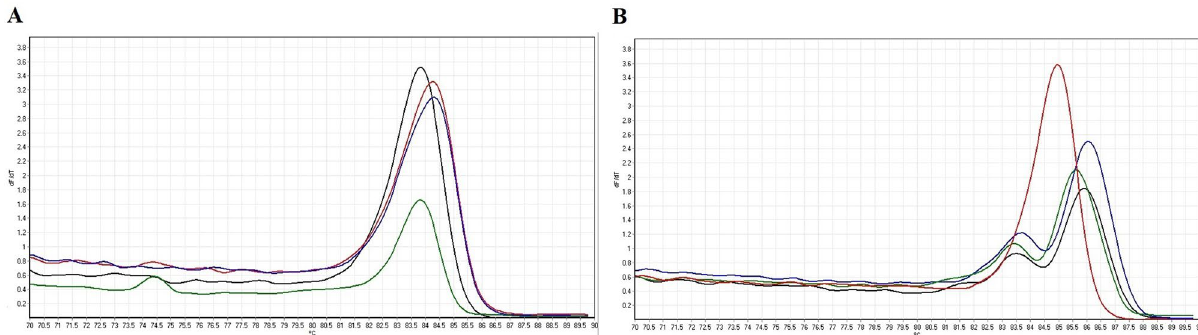
Figure 2. Melting curves of the reference strains of Shigella species analysed by PCR-HRM using ( A ) purA-F-R and ( B ) rrsA-F-R primer pairs. Green curve: S. dysenteriae . Red curve: S. flexneri . Blue curve: S. boydii . Black curve: S. sonnei .